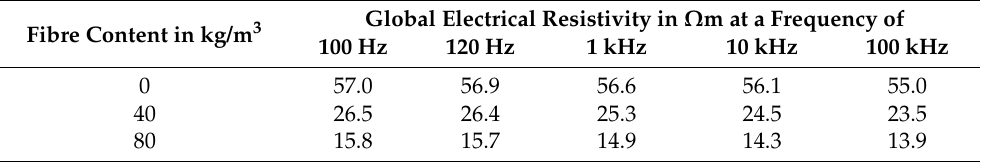
Table A38. Results of the resistivity measurements of the concrete mixture 32-60-300-00 after storage in H 2 O for 56 days for the investigations of possible leaching effects.